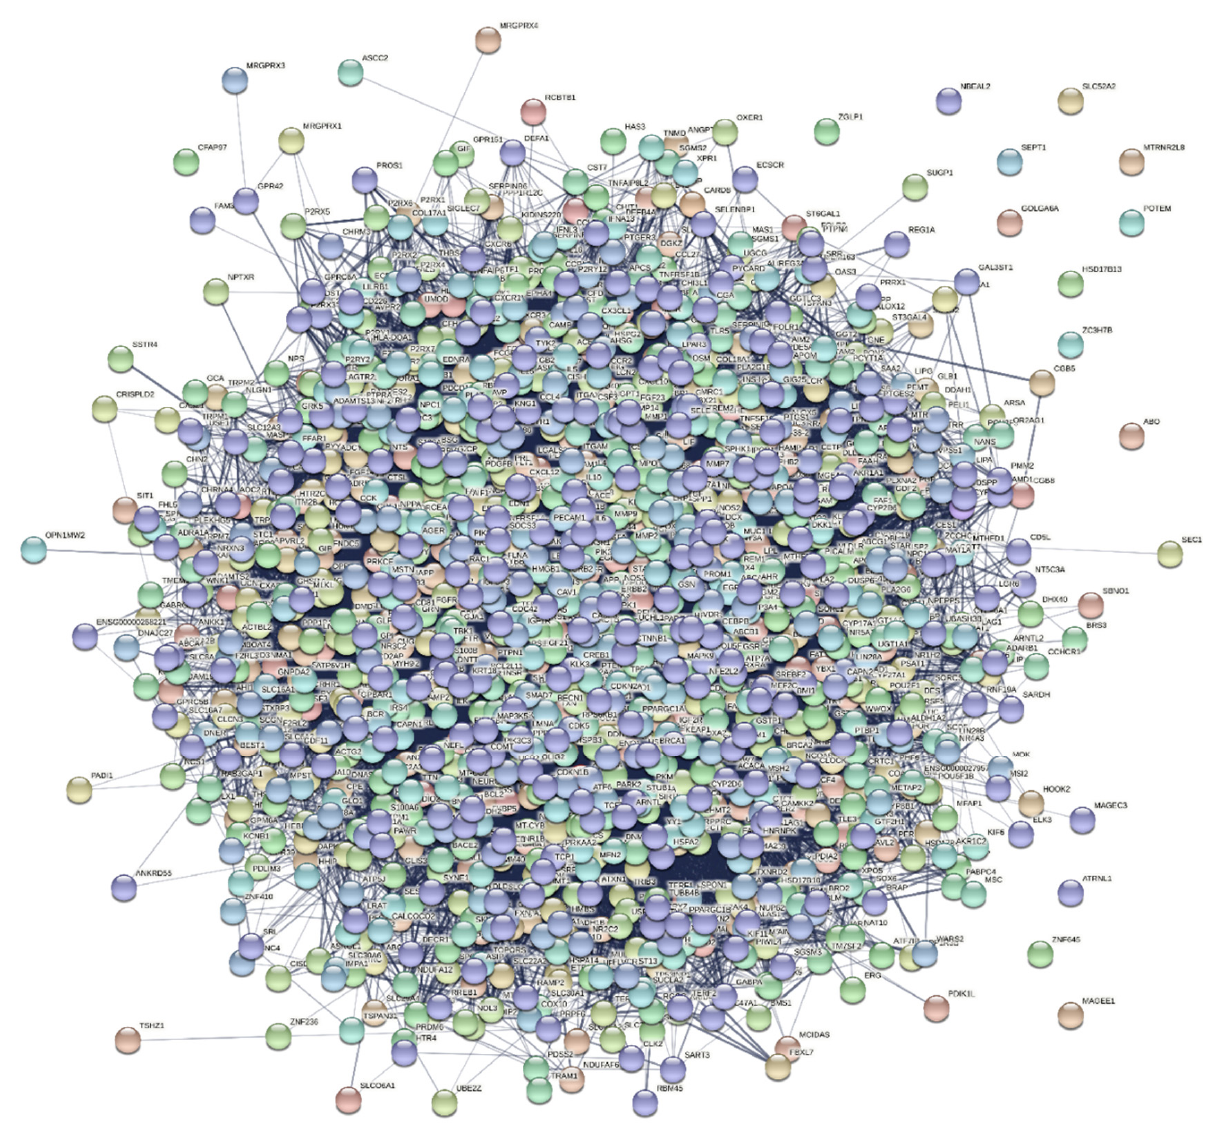
Figure 2. The interaction network of common genes built using STRING for T2D and AD.